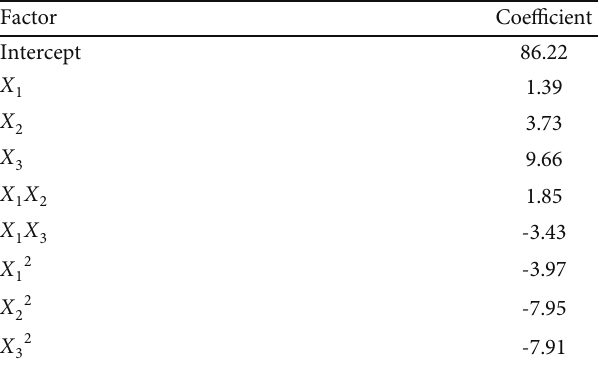
Table 9: Model coe ffi cients for the reduced model (Source: Design- Expert 13 Software).